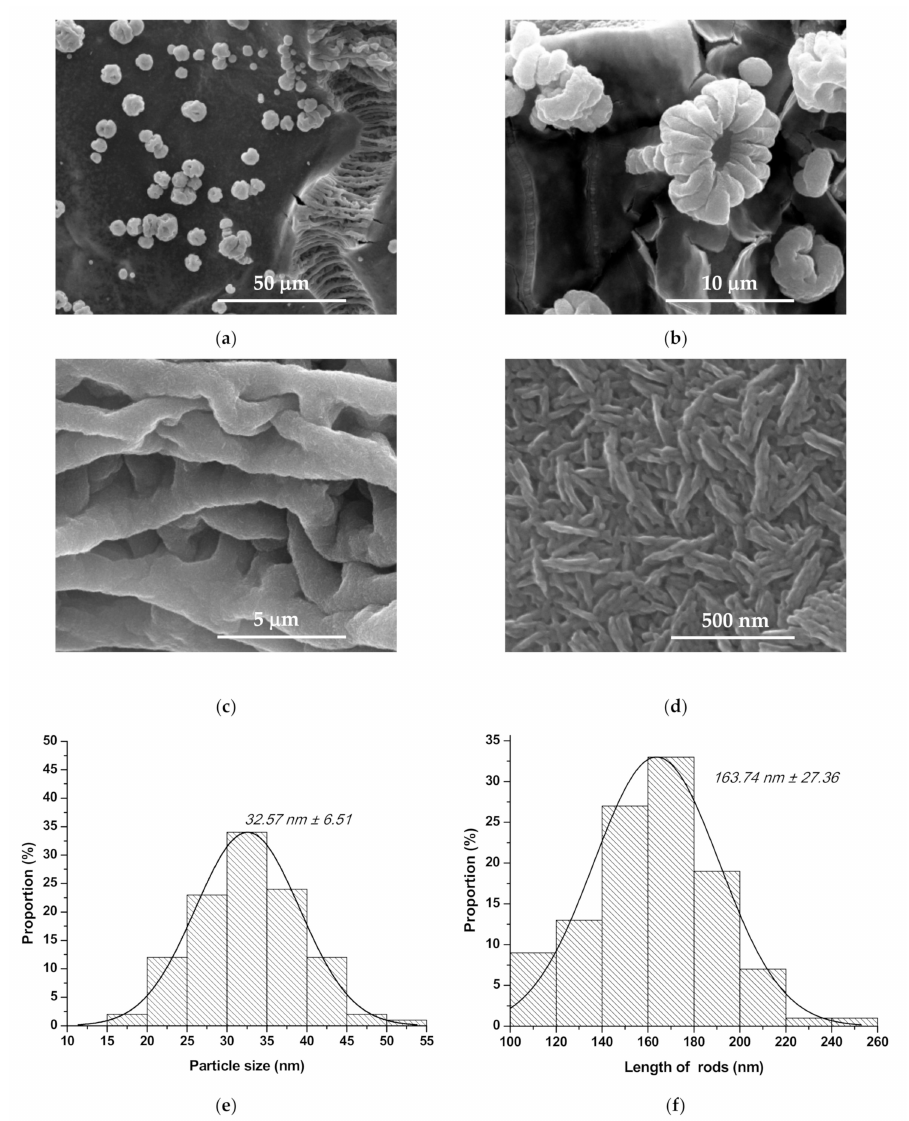
Figure 4. SEM images ( a – d ) and grain size distribution (( e )—quasi-spherical particles; ( f )—rods shape agglomerates) for Co 2 + doped ZnO